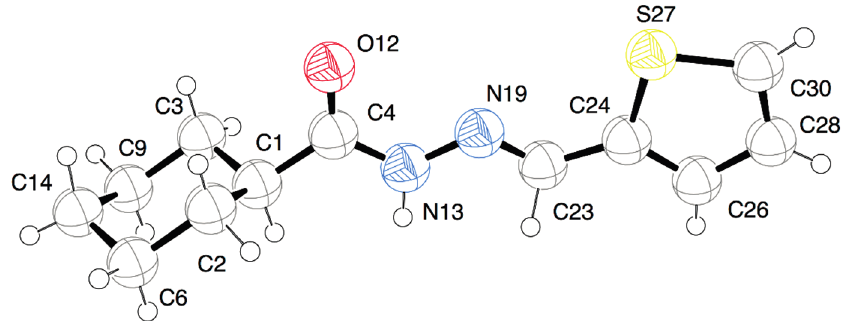
Figure 5. View of representative NAH derivative LASSBio-1515 ( 10 ) by X-ray powder diffraction Red = oxygen (O); blue = nitrogen (N); yellow = sulfur (S), black = carbon (C); and white = hydrogen